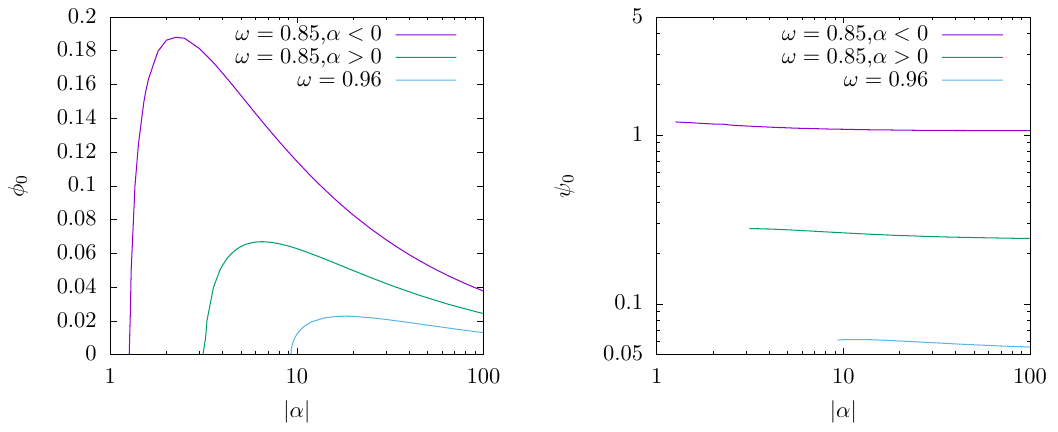
Figure 8 . We give the value of φ 0 (left) and ψ 0 (right) as function of solid) and negative (green solid) α branch, respectively, for ω = 0 . 85. For comparison, we also give the values for ω = 0 .